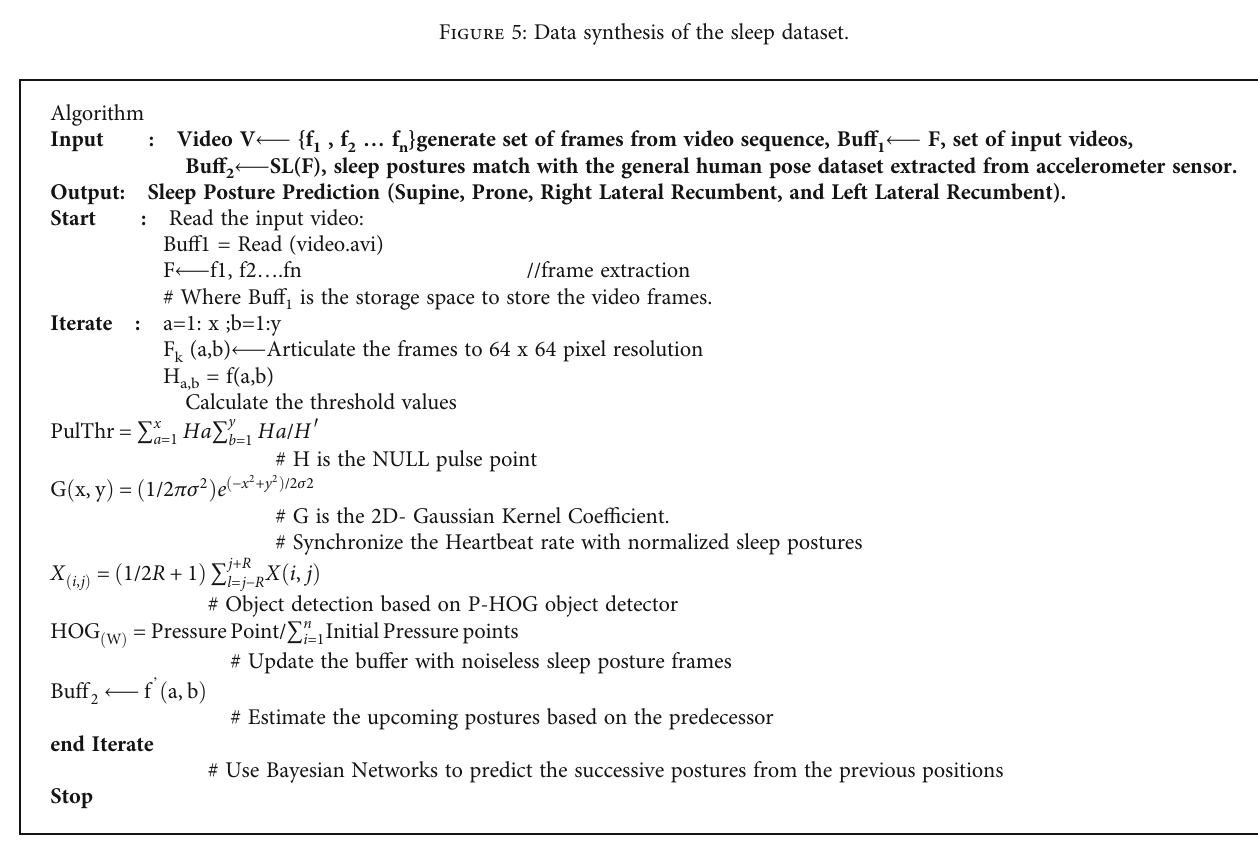
Algorithm 1: Posture prediction-Bayesian network